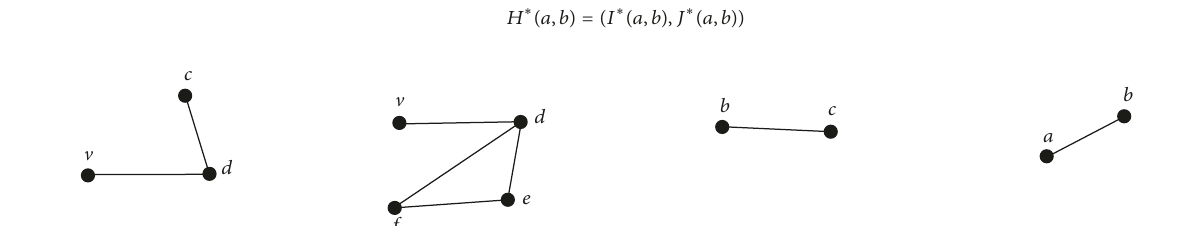
Figure 9: 𝐴𝑁𝐷 operations on G ∗ and G ∗󸀠